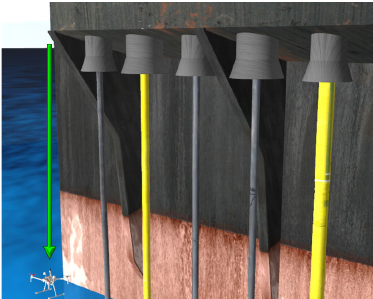
Figure 7. Vertical trajectory performed for image acquisition.